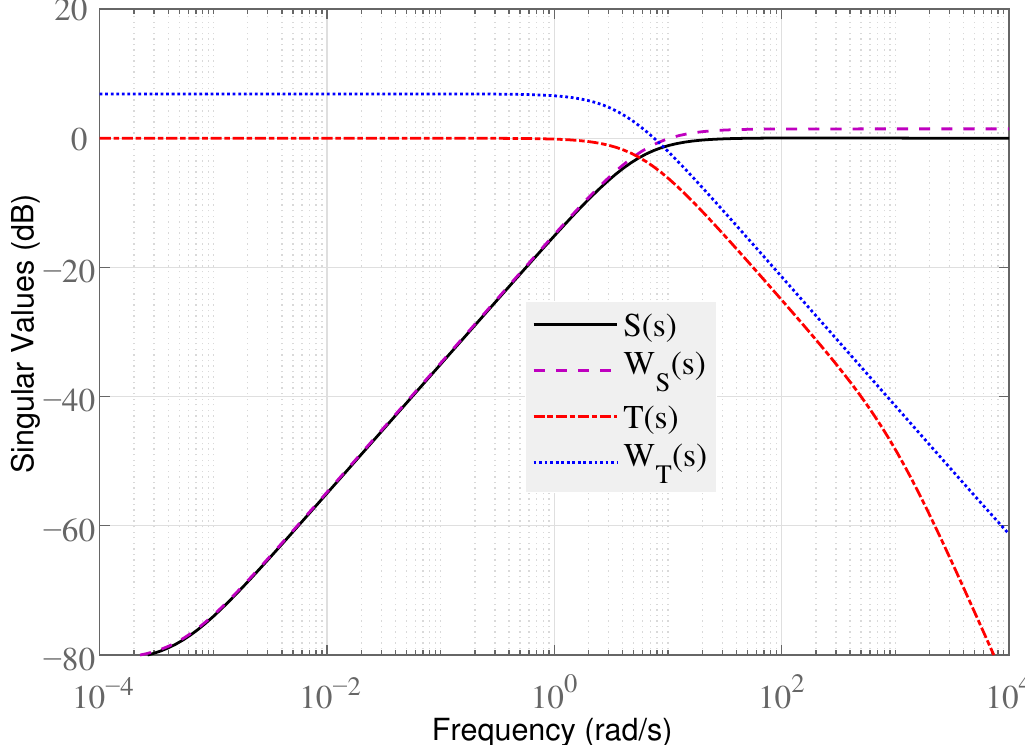
Figure 4. Sigma plot of different sensitivity and weighting functions.